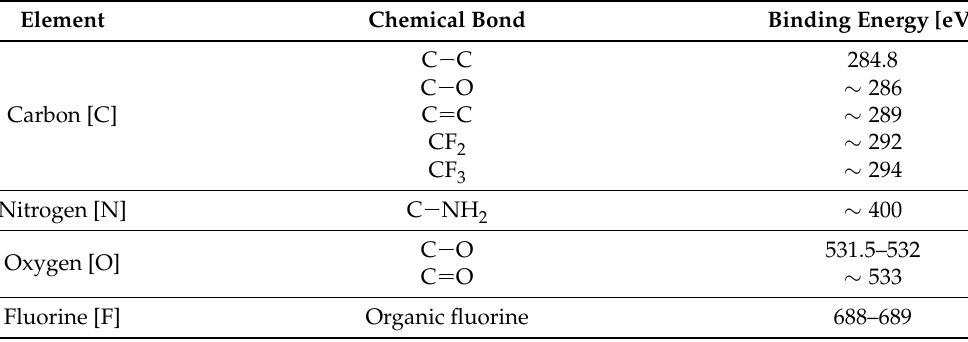
Table 2. Reference values of carbon binding energies [20].